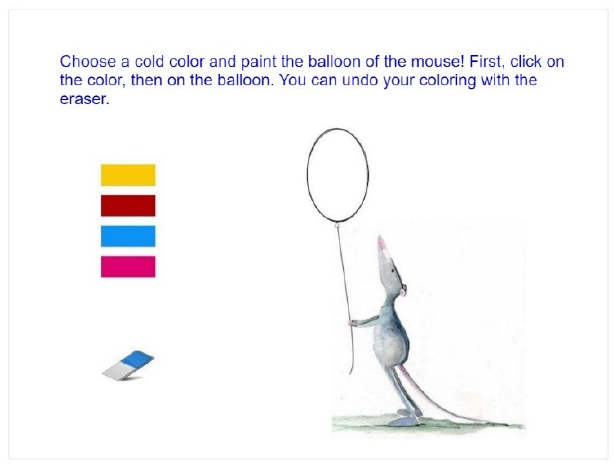
Figure 7. Recognition and differentiation task (task for Grade 5, age 11 years).